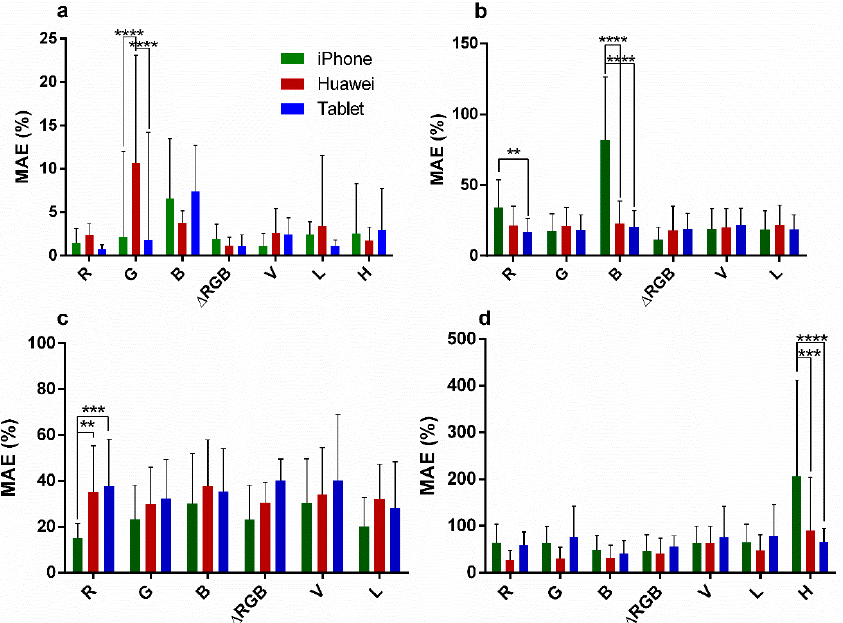
Figure 7. Mean average percentile errors (MAEs) for pH ( a ), (LNP) ( b ), (GNP) ( c ), and (CB) ( d ) predictions using an iPhone (dark green), Huawei (dark red), or Tablet (blue). Significant post-hoc Sidak multi comparisons of two-way ANOVAs are indicated. Stars indicate p -values with p -value correction for multiplicity. ** = p < 0.01, *** = p < 0.001, **** = p <